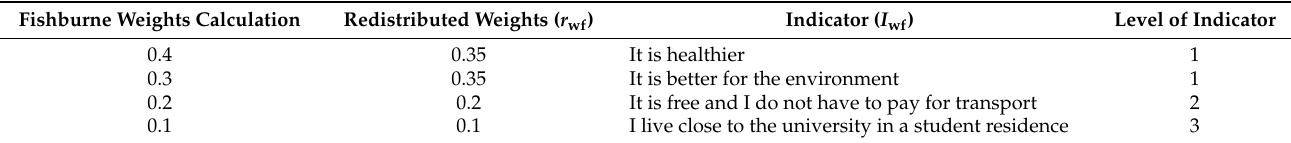
Table 21. Reasoning indicators for walking by foot.